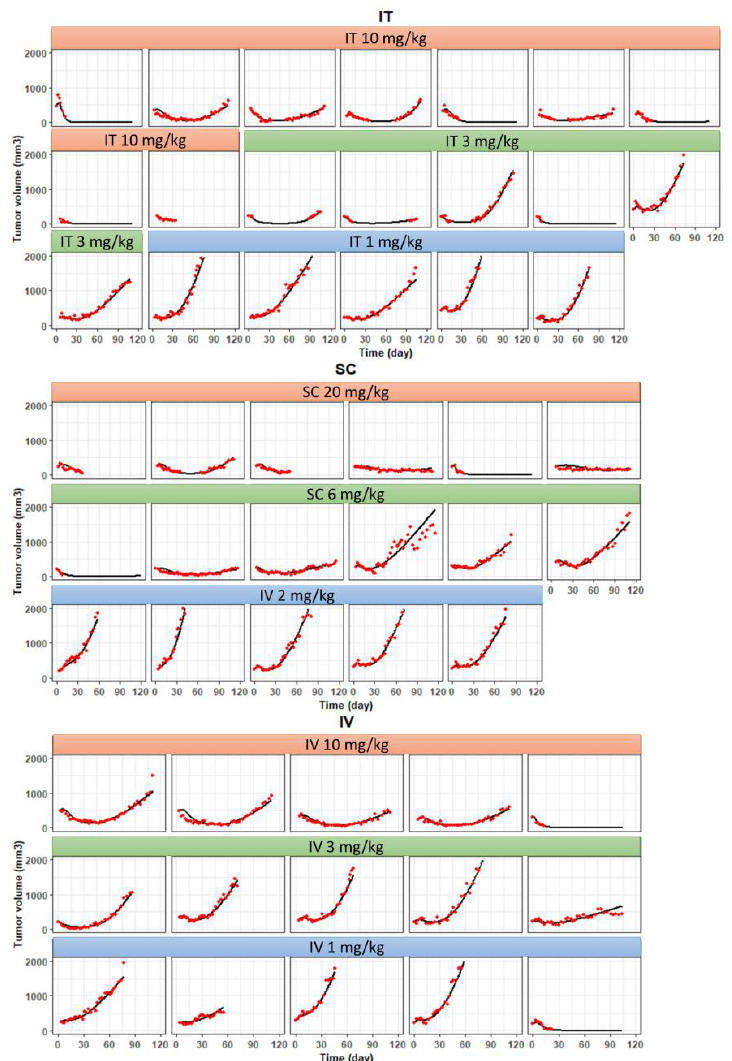
Figure 8. Comparison of PK/PD model fitted and observed tumor growth curves after treatment with T-vc-MMAE administered via intravenous (IV), intratumoral (IT), and subcutaneous (SC) curves after treatment with high (red bar), mid (green bar), and low (blue bar) ADC